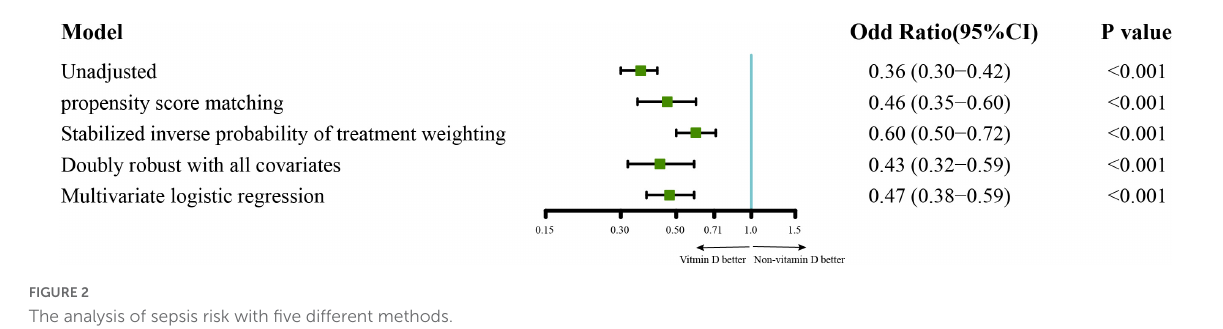
FIGURE2 The analysis of sepsis risk with five different methods.